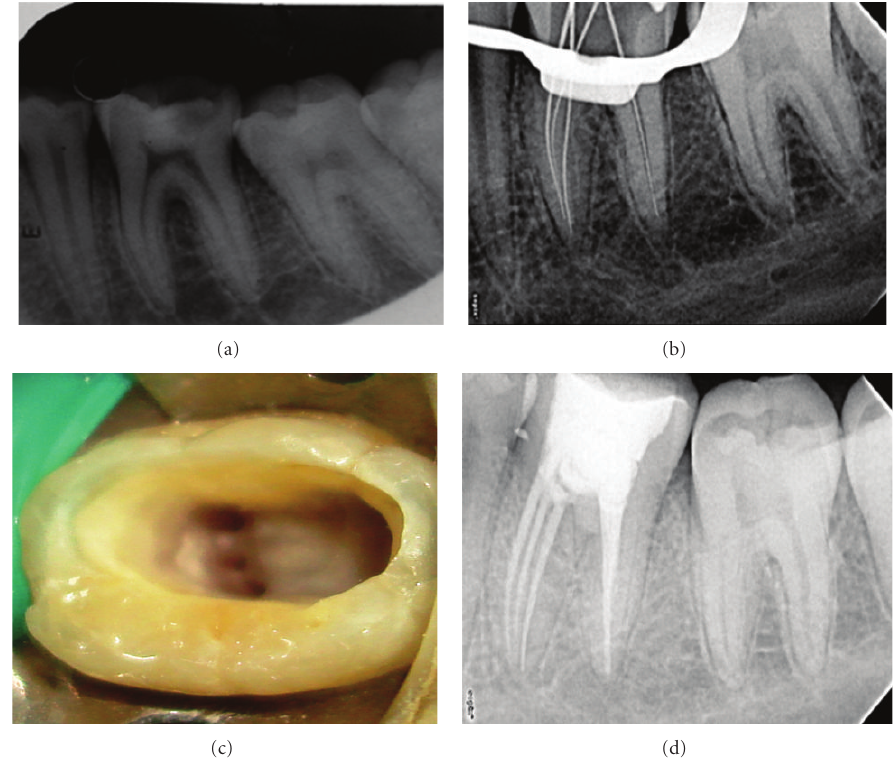
Figure 1: (a) Preoperative radiograph. (b) Working length. (c) Clinical image. (d)